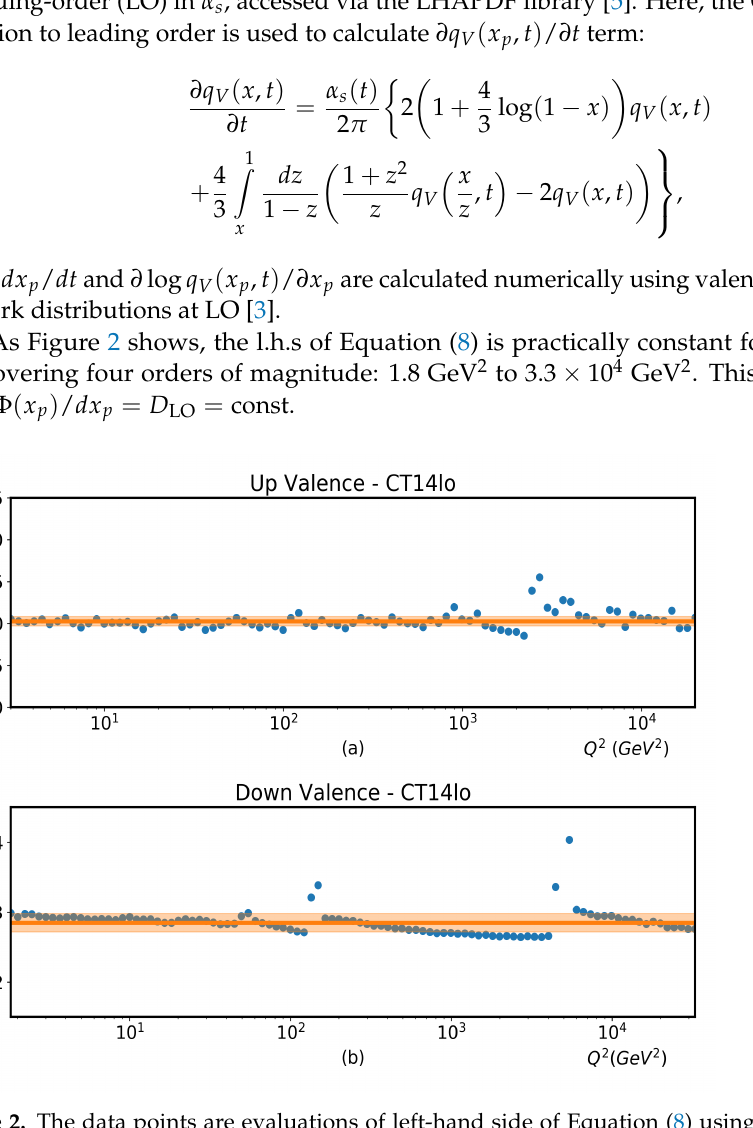
Figure 2. The data points are evaluations of left-hand side of Equation (8) using CT14 lo parton distribution functions (PDFs) [3] for valence u-quark ( a ) and d-quark ( b ) distributions in the proton. The factor D is the average value of evaluations of Equation (8) with shaded area representing the standard deviation of calculated